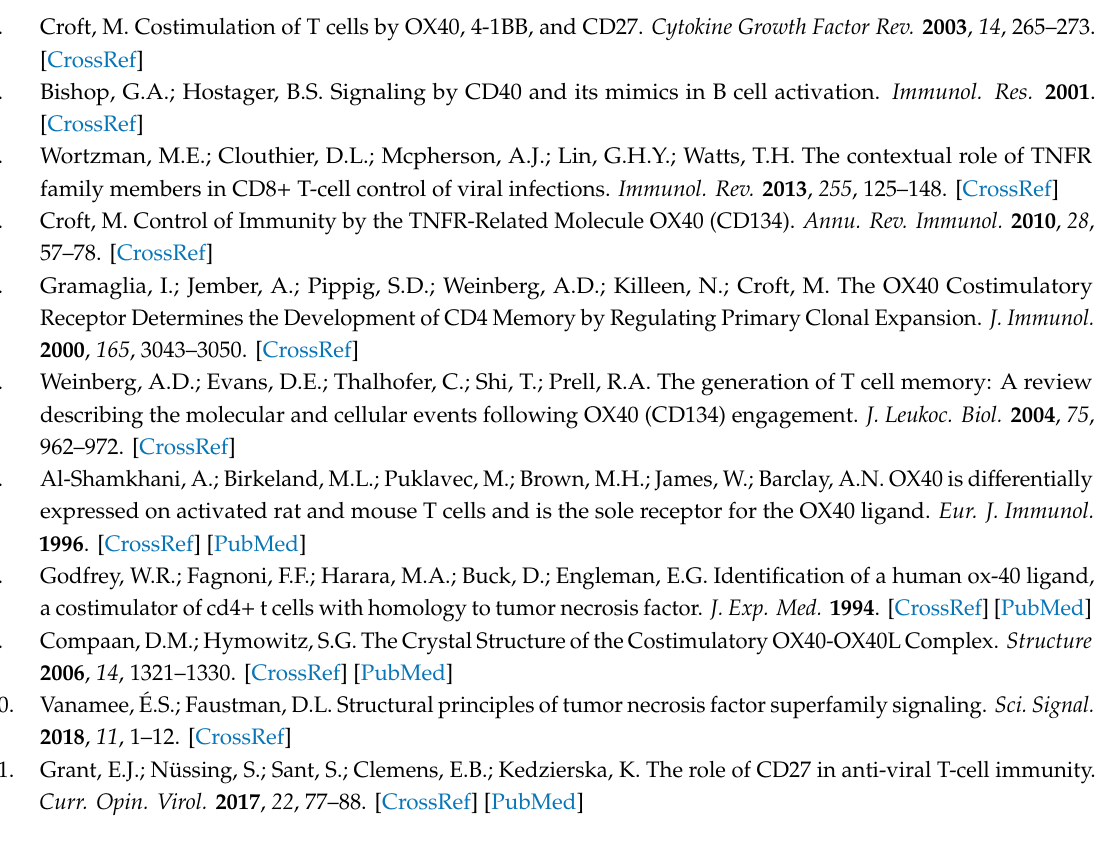
Figure S1: A. Multiple sequence alignment of mammalian OX40R (TNFRSF4) proteins B. Multiple sequence alignment of mammalian CD27 (TNFRSF7) proteins C. Multiple sequence alignment of mammalian OX40L (TNFSF4) proteins D. Multiple sequence alignment of mammalian CD70 (TNFSF7)